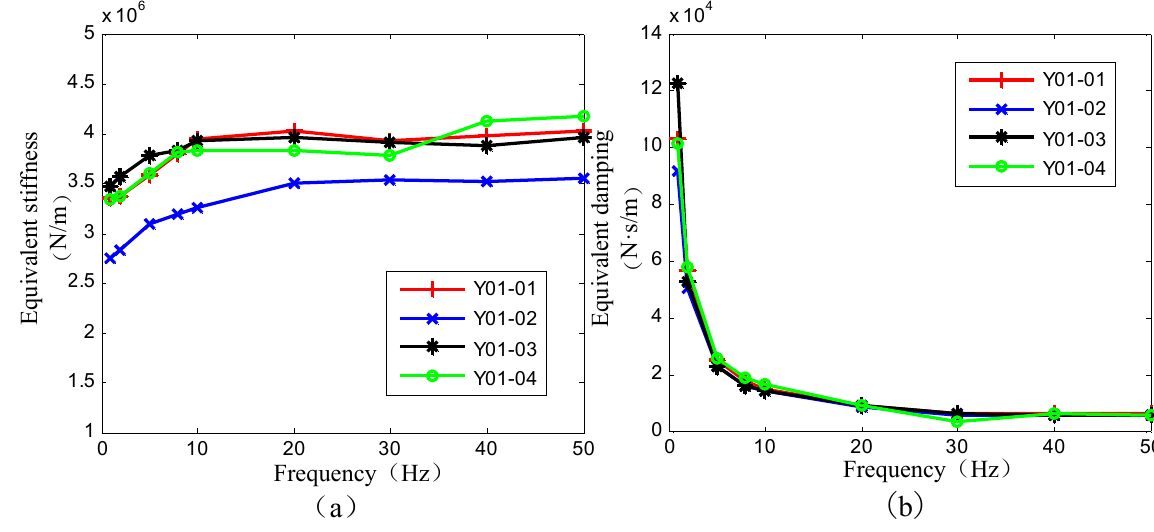
Figure 13. Dynamic parameters of specimens Y01 ‐ 01~04 vary with frequency at 0.2 mm: ( a ) equivalent stiffness and ( b ) equivalent damping.